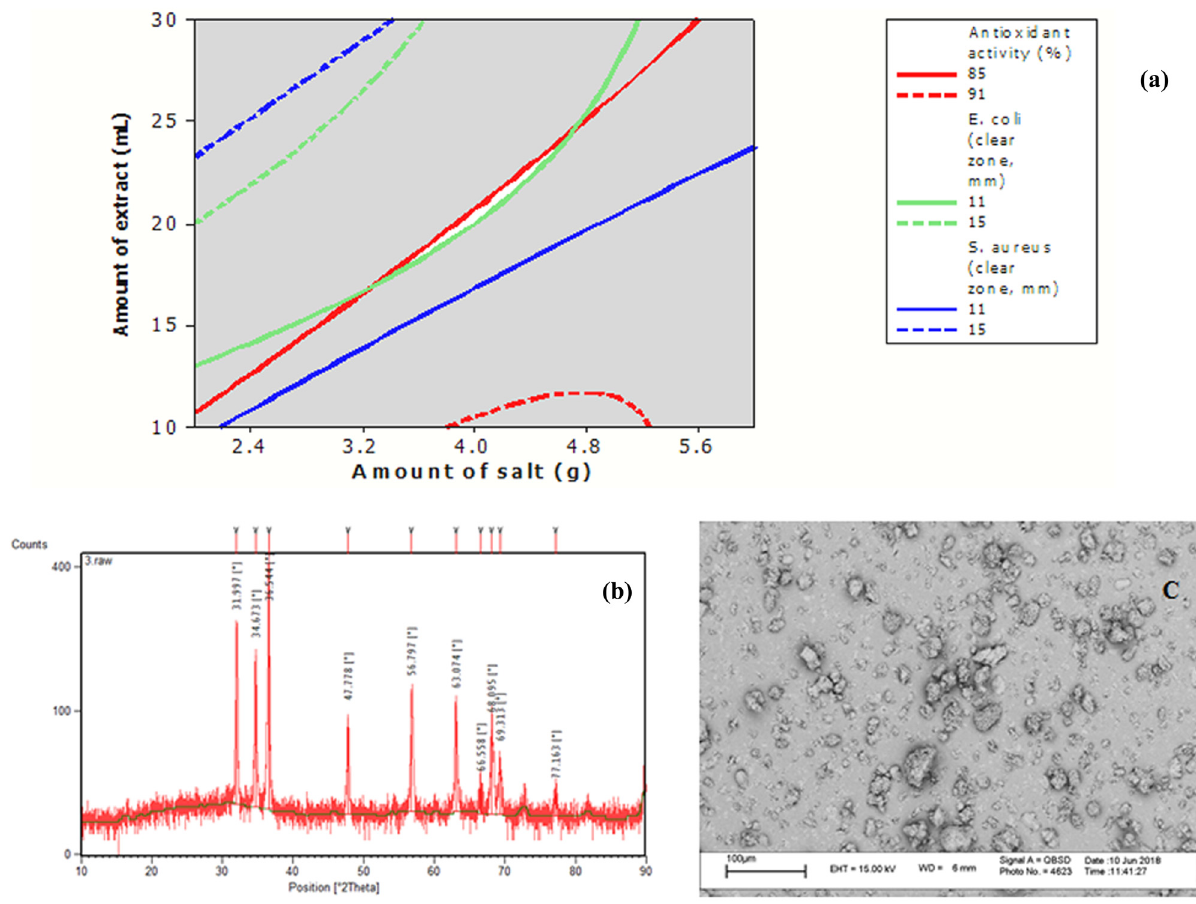
Figure 4: Overlaid contour plot of ZnO NPs ’ antioxidant and antibacterial activities with acceptable levels as function of amounts of zinc salt ( g ) and clove extract ( mL ) ( a ) , XRD pattern ( b ) , and SEM image ( c ) of the fabricated ZnO NPs using clove ( Syzygium aromaticum Linn ) extract and obtained optimum synthesis